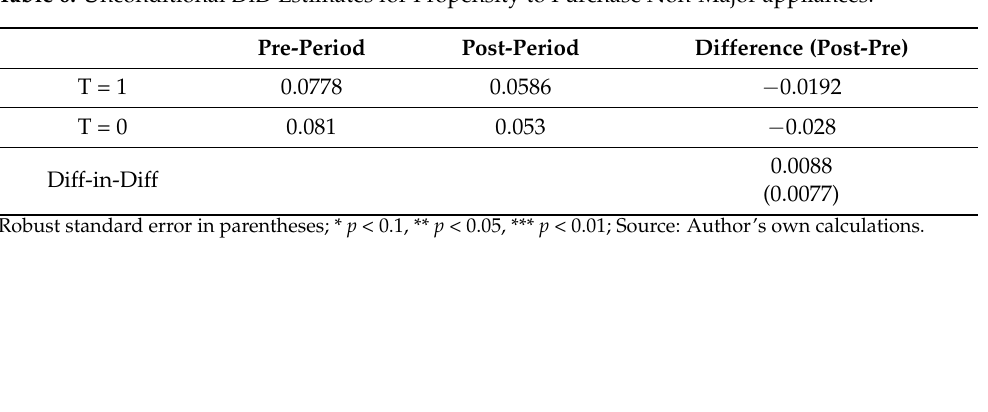
Table 6. Unconditional DiD Estimates for Propensity to Purchase Non-Major